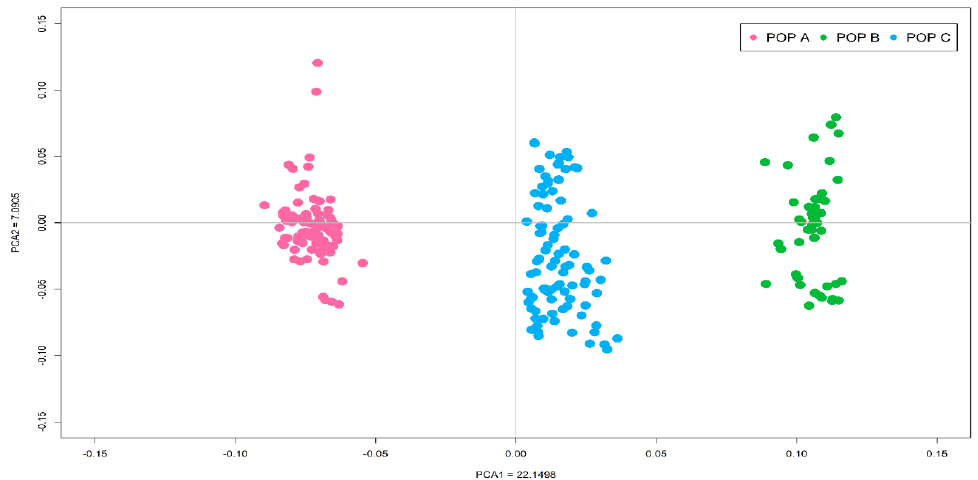
Figure 1. Principal component analysis of the autosomal genotypic data of three coho salmon